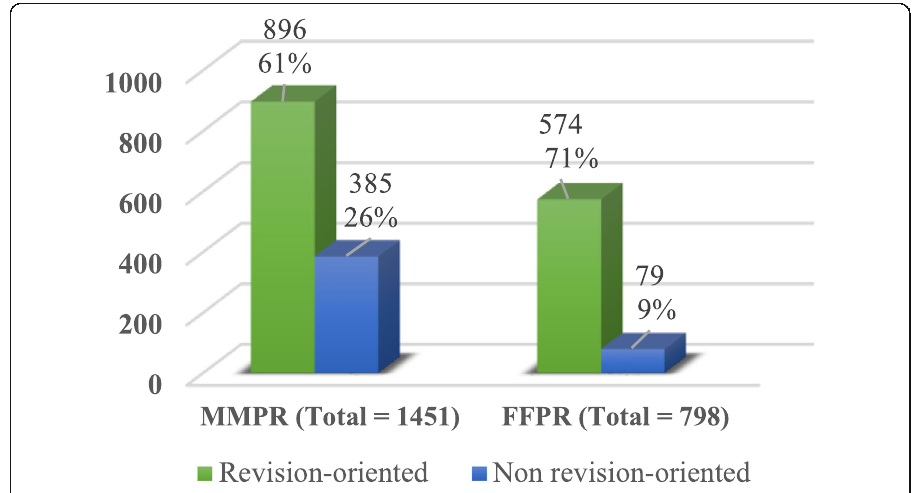
Fig. 5 Feedback distribution percentage by group and by nature (after alternation feedback